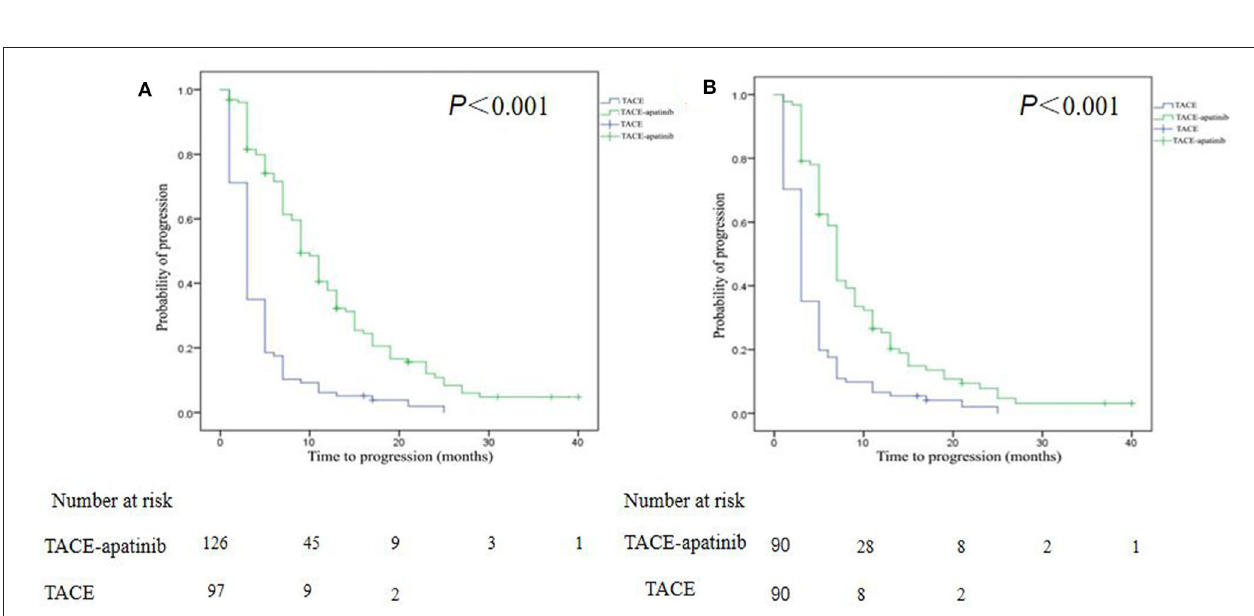
FIGURE 3 | Kaplan–Meier curves of time to progression for patients with advanced hepatocellular carcinoma who received the treatment of transarterial chemoembolization (TACE)–apatinib or TACE alone before (A) and after (B) propensity score matching.